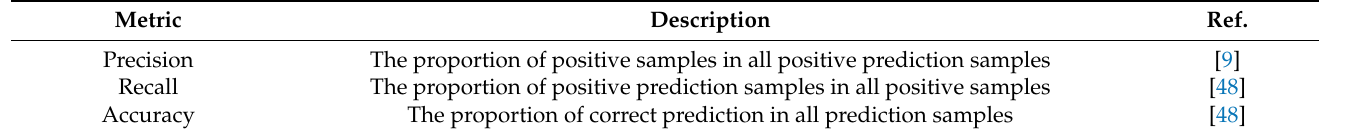
Table 7. Overview of the evaluation metrics in the recent